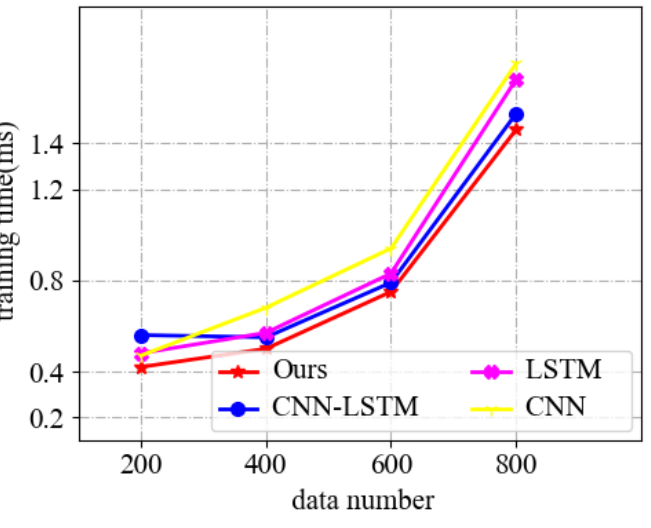
Figure 14. Comparison of the training times of different models.